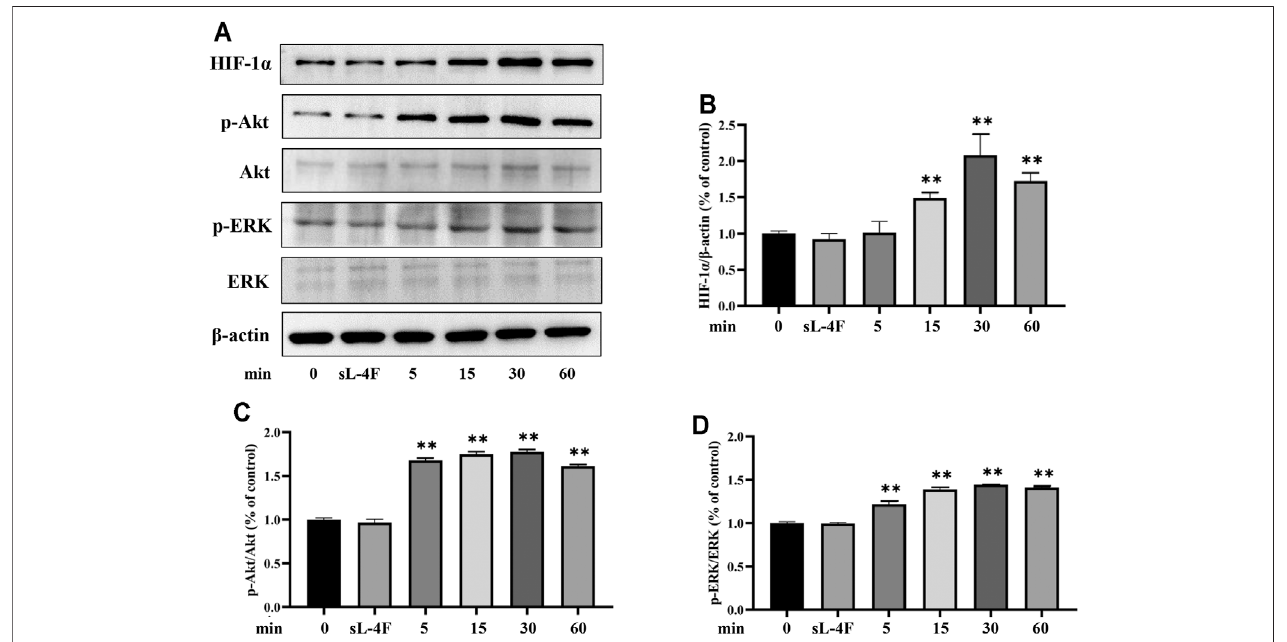
FIGURE 5 | (A) Representative Western blot images. L-4F upregulates protein levels of HIF-1 α (B) , p-Akt (C) , and p-ERK (D) in HUVECs at different time points. Cells were treated with L-4F (50 μ g/ml) for 0, 5, 15, 30, and 60 min, respectively, or sL-4F at 50 μ g/ml for 30 min, n (cid:1) 3, one-way ANOVA, Dunnett ’ s test, ** p < 0.01, compared with control.